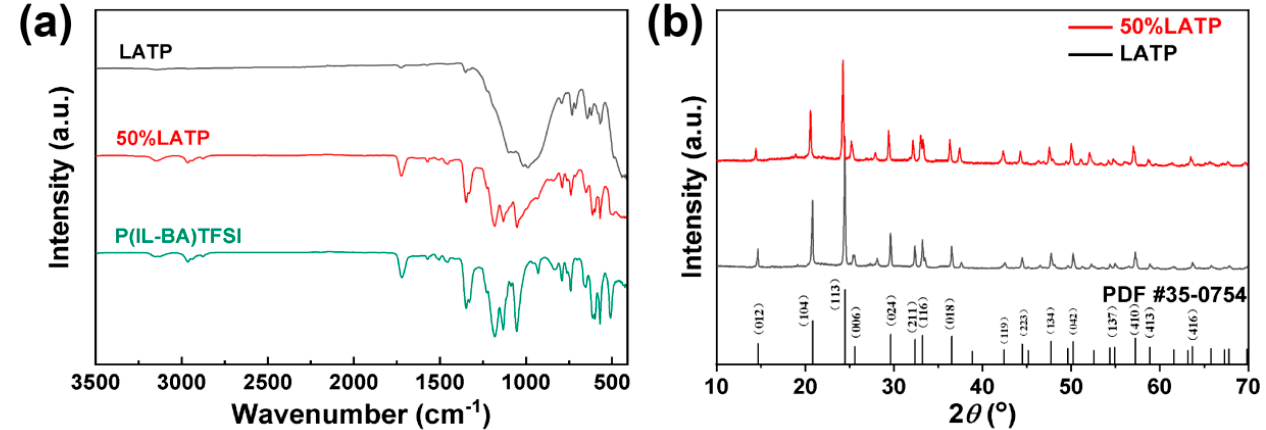
Figure 1. FT − IR spectra ( a ) and XRD patterns ( b ) of composite electrolytes.